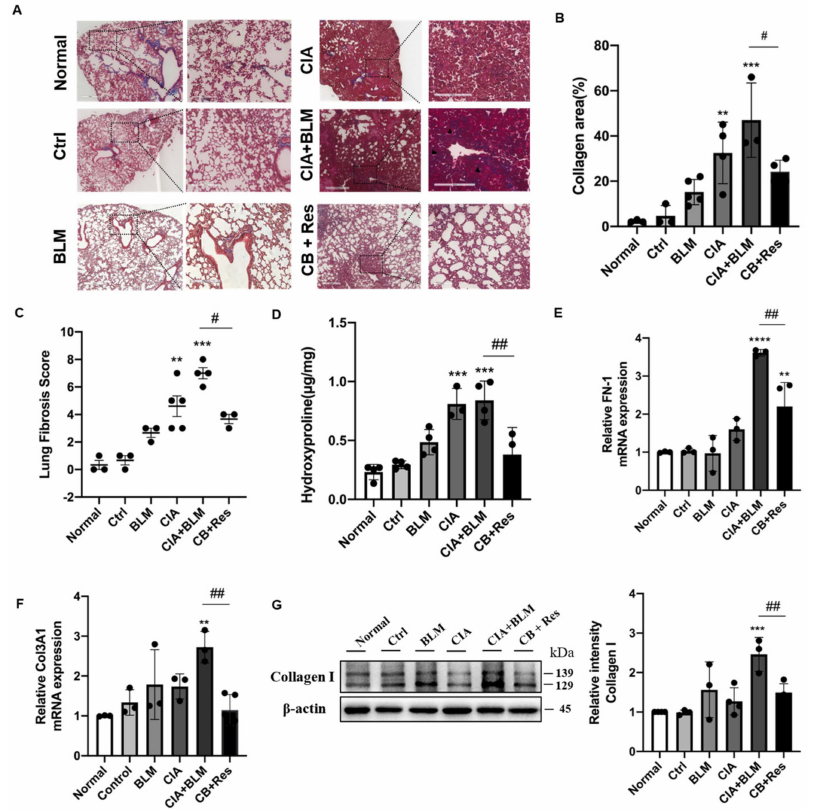
Figure 3. Resveratrol treatment attenuated lung fibrosis in CIA+BLM mice. ( A ) Representative image of pulmonary Masson’s staining shown at 40 × (left panels) and 200 × (right panels) magnification. Scale bar, 50 µ m. Black arrows indicate the bands of fibrous tissues. ( B ) Quantitative analysis of the collagen area of each group. ( C , D ) Assessments of fibrosis in each group and levels of hydroxyproline in the lung were measured. ( E , F ) The mRNA levels of FN-1 and COL3A1 were quantified. ( G ) The levels of collagen I in the lungs were detected using immunoblotting and were quantified as described above. Values represent the mean ± SEM (n = 3–5). Compared with the control group, ** p <0.01, *** p <0.001 and **** p <0.0001; compared with the model group (CIA+BLM), # p < 0.05 and ## p <